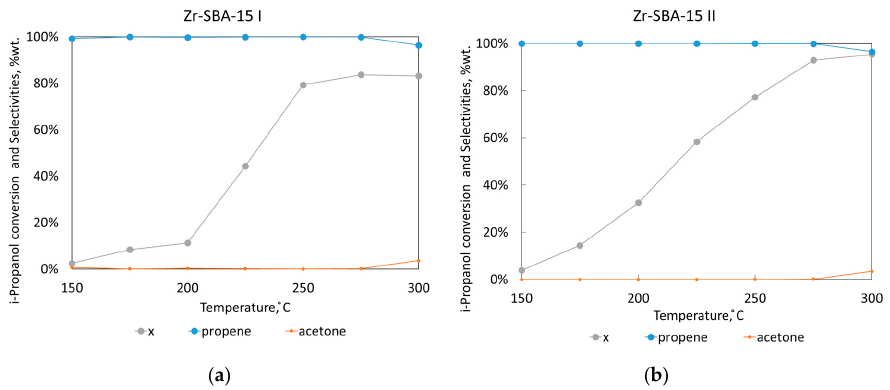
Figure 8. Isopropanol conversion and selectivity to propene and acetone for the Zr ‐ SBA ‐ 15 I ( a ) and Zr ‐ SBA ‐ 15 II ( b ) catalysts.